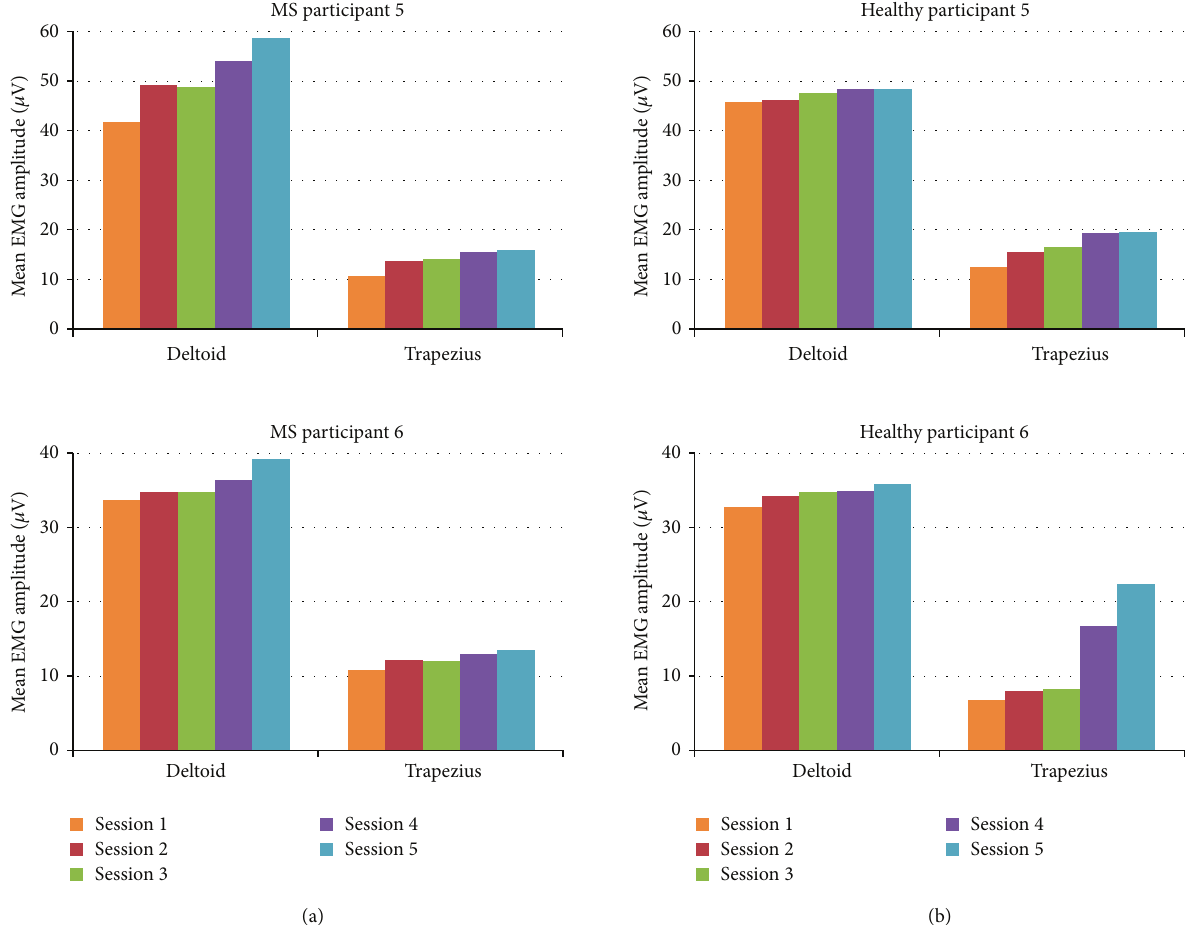
Figure 5: Mean EMG amplitudes of the anterior deltoid and lower trapezius muscle over the 5 training bouts (3 󸀠 each): MS participants (a) and healthy participants